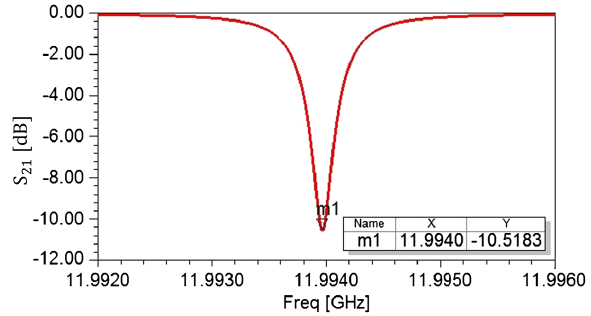
FIG. 10. S 21 frequency sweep of the correction cavity system.